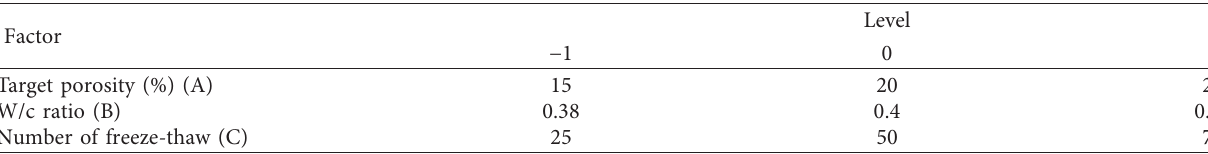
Figure 4: Normalized permeability coefficients after clogging caused by different head Table 9: Design test factors and their level.